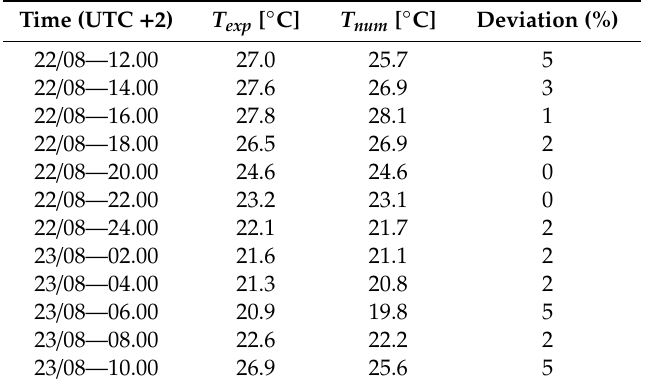
Table A1. Comparison between temperatures measured in Marconi street ( T exp ) and those obtained by the Computational Fluid Dynamics (CFD) simulations (T num ).